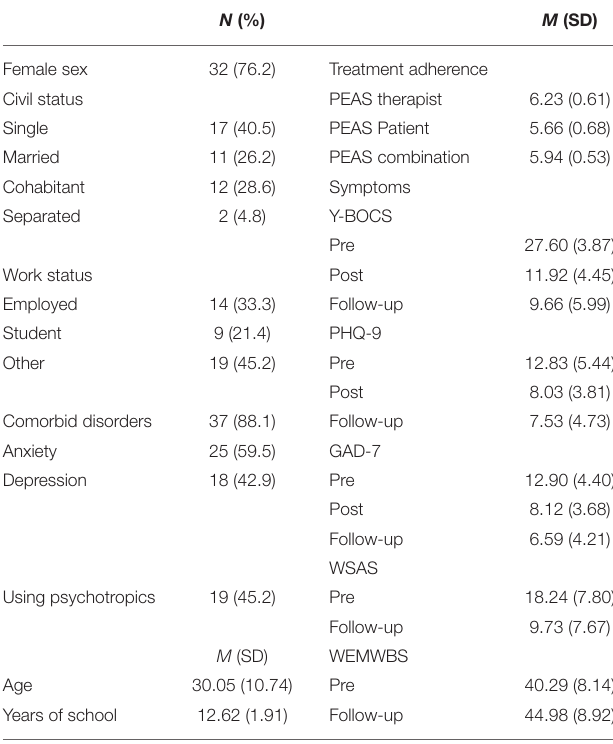
TABLE 1 | Sample characteristics and change in symptoms, well-being, and work- and social functioning. N